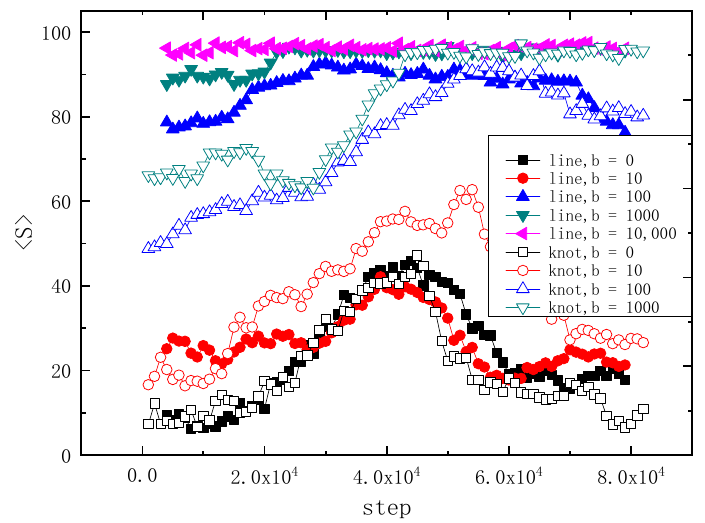
Figure 6. Average end-to-end distances <S> of linear chain and trefoil knot chain, with different bend parameter b, variate with the time step. There are 100 monomers in each polymer chain. The filled symbols indict the linear chain, and the hollow symbols represent the 3 1 knot chain; the same shape and color online symbols represent the same rigidity.